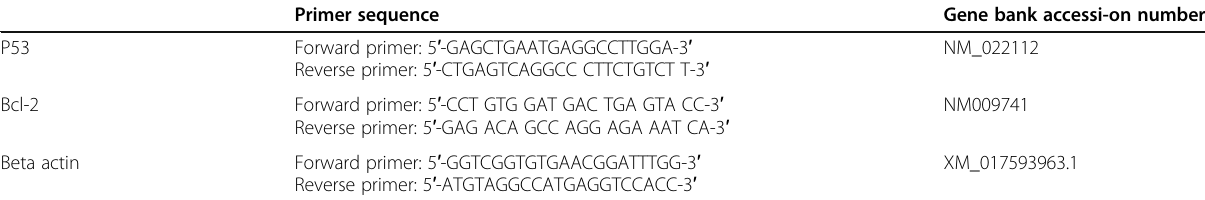
Table 1 Primer pairs used for qPCR Primer sequence Gene bank accessi-on number